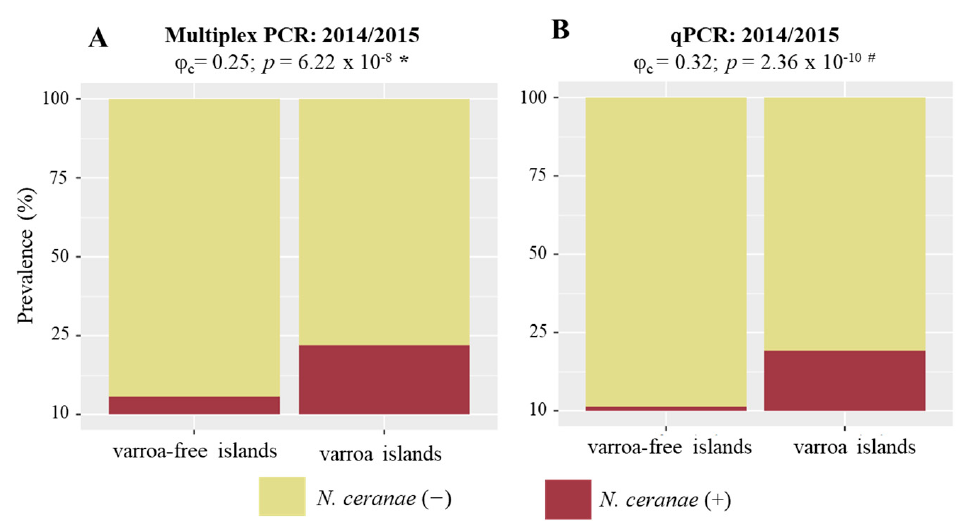
Figure 5. N. ceranae prevalence for the islands with and without V. destructor for the 2014/2015 sampling period. ( A ) multiplex PCR prevalence between islands with and without V. destructor ; ( B ) real-time qPCR prevalence between islands with and without V. destructor . The strength of the association between the two parasites was evaluated by Cramer’s V (<0.1–0.3: weak; 0.3–0.5: moderate; >0.5: strong) and the significance of the association by the Chi-square Test (*) or Fisher’s exact test ( # ).